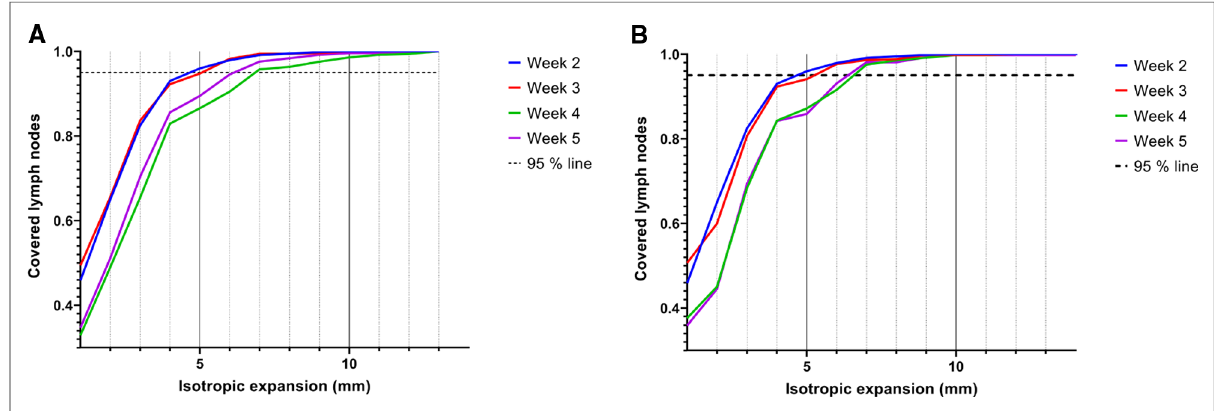
FIGURE 5 Coverage of elective lymph nodes in the scans of week 2, 3, 4 and 5 when the segmented volumes of the pre-treatment scan ( A ) or the previous scan ( B ) were isotropically expanded. Lymph nodes were considered covered if 95% of all voxels were within the expanded